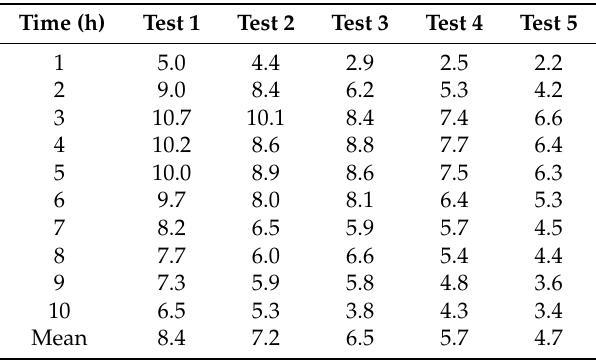
Table 3. The temperature difference of the inlet and outlet air for five tests (°C).